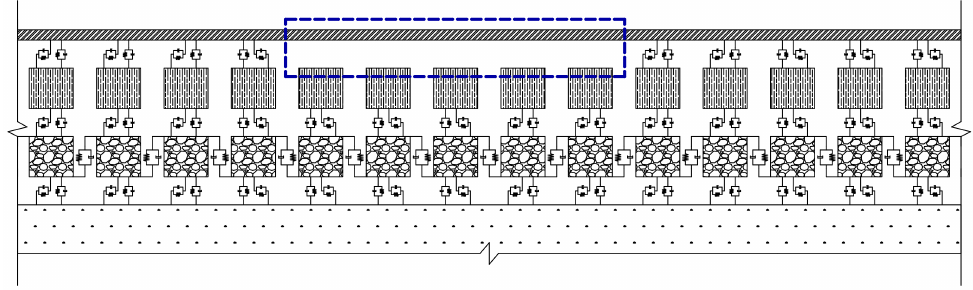
Figure 14. Illustration of the occurrence of one failed rail fastener (enclosed by the dashed